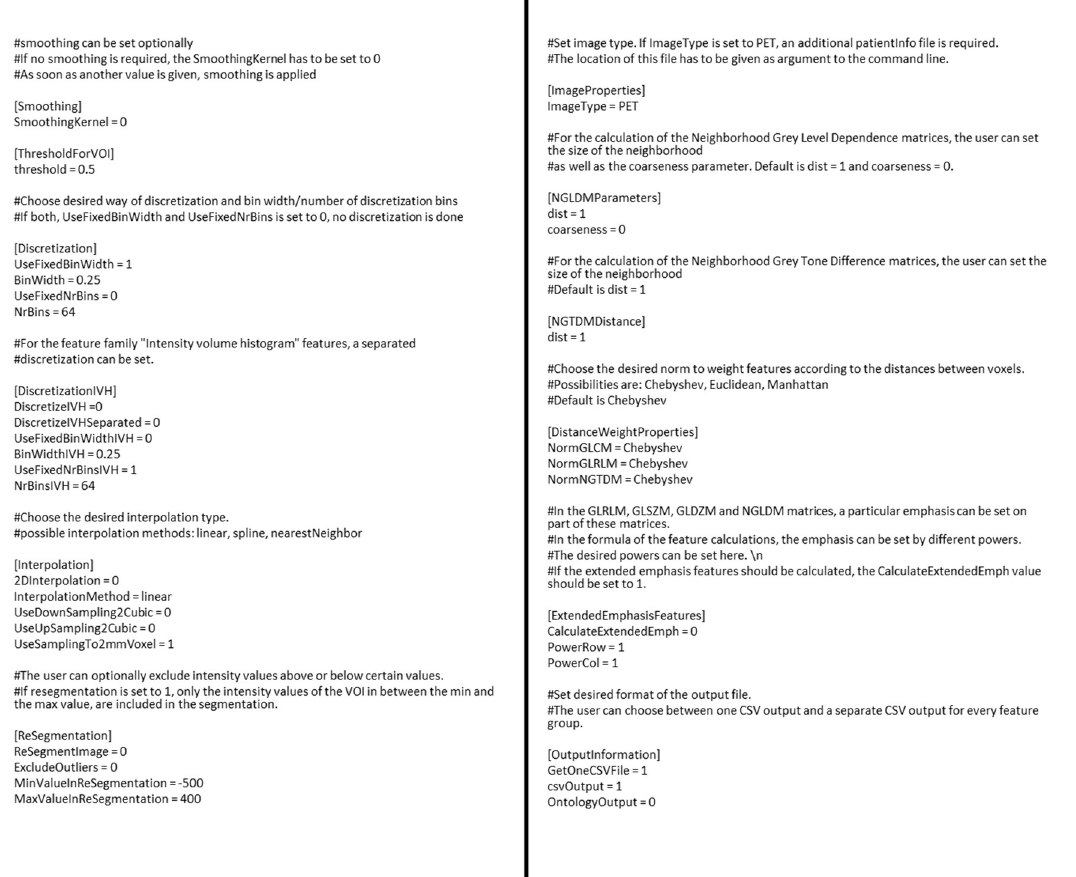
Fig 4. Example of configuration file. The user can set the required preprocessing steps, like e.g. re-segmentation by setting the ReSegmentImage parameter from 0 to 1. Other parameters like the number of bind (NrBins) can also be set to any required value.